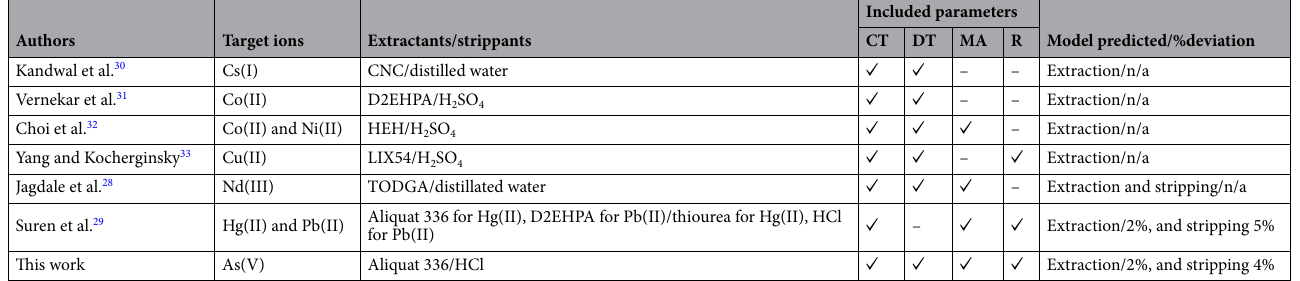
Table 1. Mathematical models used for predicting the elimination of metal ions via HFSLM. CT, convection transport; DT, diffusion transport; MA, mass accumulation; R,